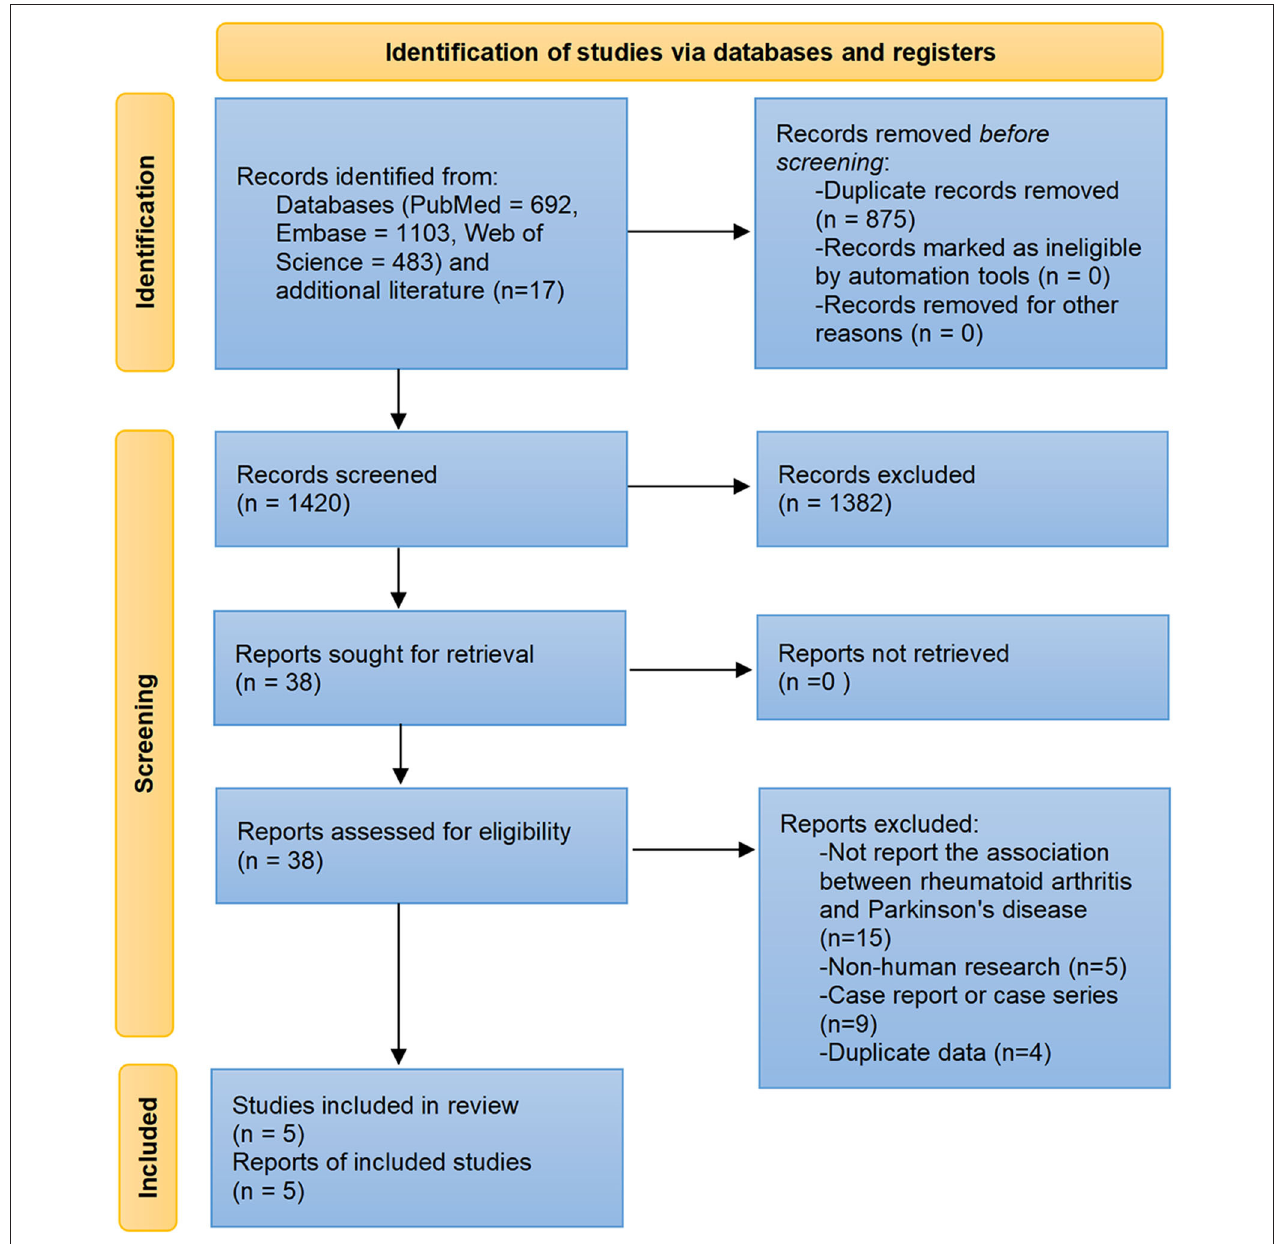
FIGURE 1 | Flow diagram of the study selection